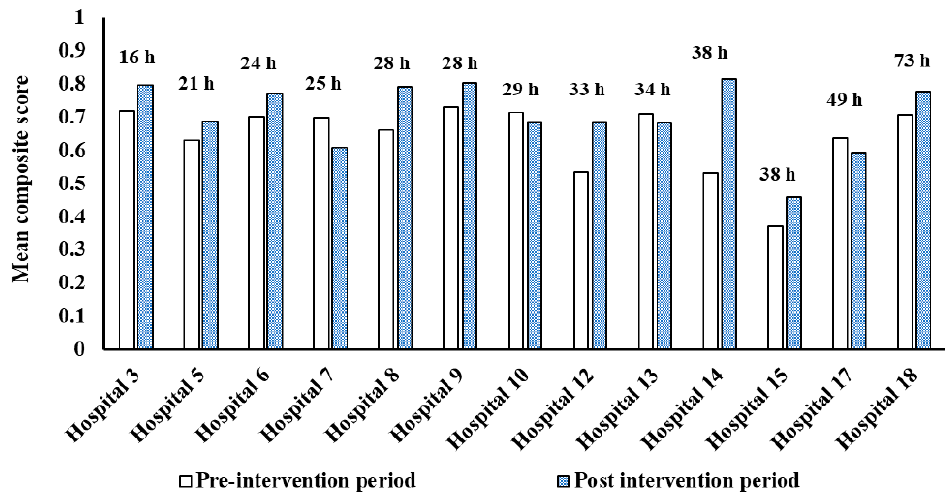
Figure 3. Change in composite score from acute stroke processes of care nominated by hospitals in their action plans (i.e., only includes hospitals that developed an action plan, and acute stroke processes of care nominated by hospitals in their action plan).